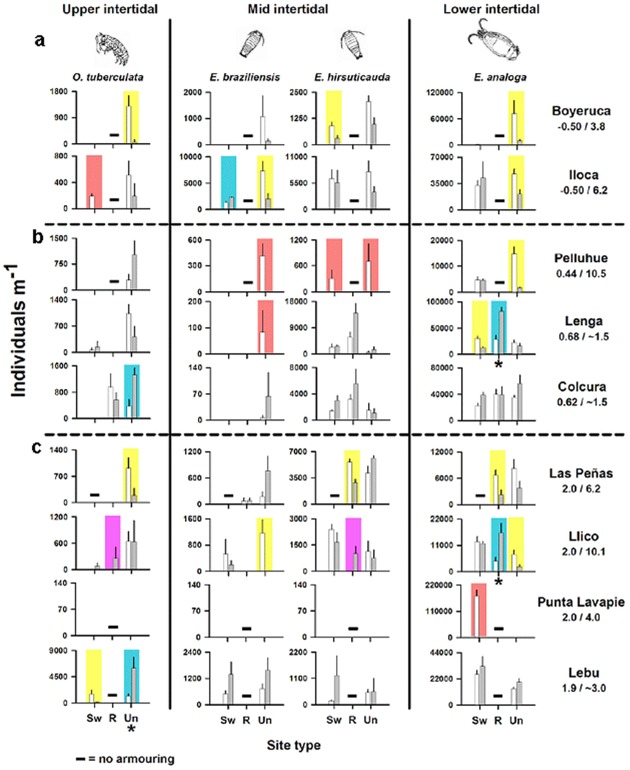
Responses of sandy beach macrofauna to the 2010 Maule earthquake.a, subsided beaches, b, beaches with <1.0 m uplift, c, beaches with 2 m uplift. Mean abundance (+1 standard error) of mobile crustaceans representing upper, mid and lower intertidal zones for before (white bars) and after (grey bars) the Maule earthquake at sites located seaward of seawalls (Sw) and rocky revetments (R), and at unarmoured sites (Un). Shaded rectangles over bars indicate: significant decrease (yellow), disappearance (red), significant increase (light blue) and first appearance of species at a site (purple). The three intertidal zones are represented by 1) the talitrid amphipod Orchestoidea tuberculata (upper), 2) the cirolanid isopods Excirolana braziliensis and Excirolana hirsuticauda (mid) and 3) the sand crab Emerita analoga (lower) as illustrated on the figure. Abundances are presented as individuals m−1 to accommodate beach width changes; trends for individuals m−2 were similar except three cases indicated by *. Note: low intertidal seaward of the seawall at Boyeruca was bedrock before and after the earthquake, excluding Emerita analoga, and the beach at Punta Lavapie is completely armoured with a seawall. Numbers below the names of sites on the right side of the figure indicate land-level changes and tsunami heights in meters (m/m, respectively) for each study beach.